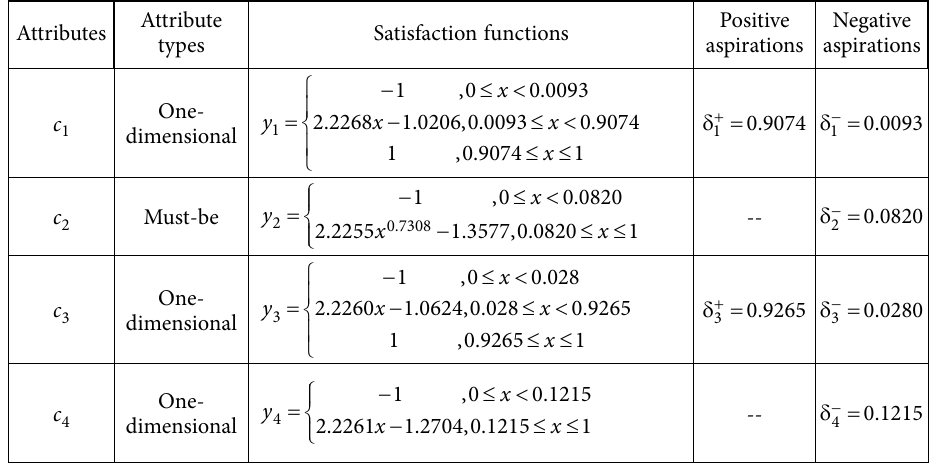
Table 9. Satisfaction functions of different